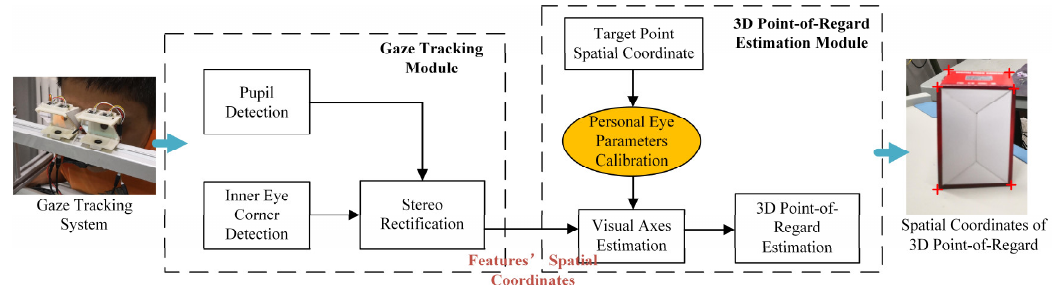
Figure 1. The diagram of the proposed 3D point-of-regard estimation method.